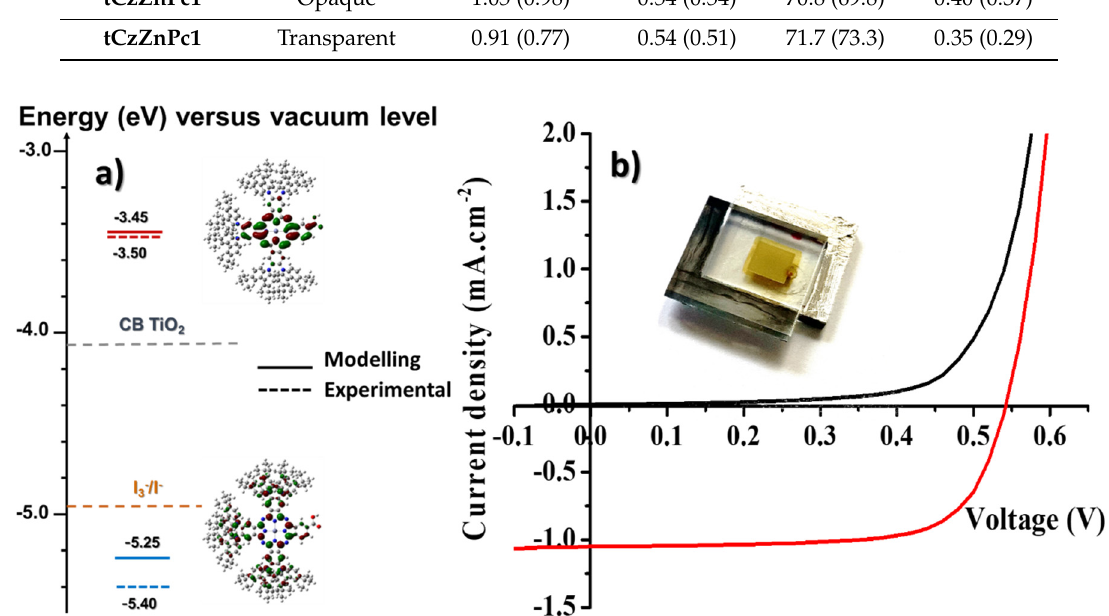
Table 1. Photovoltaic parameters of the best solar cells and mean values over 3 cells (in parenthesis). Dye Cells Opaque